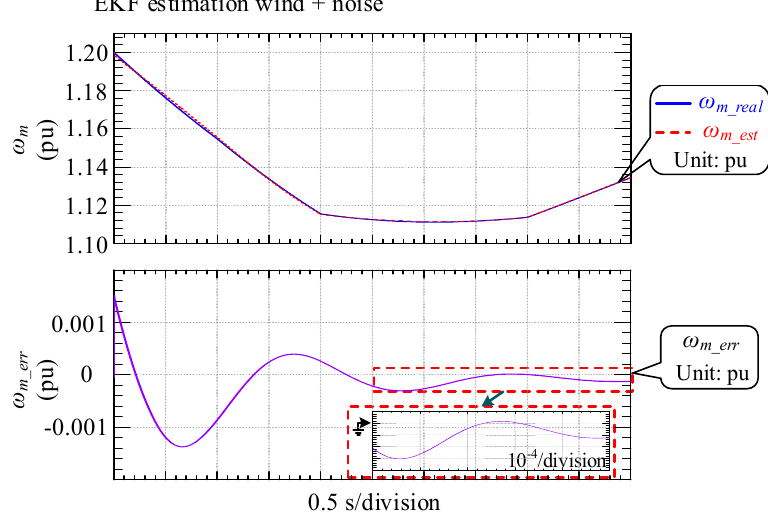
Figure 12. Real and estimated rotor angular speeds and the estimation error by using the EKF algorithm with wind speed fluctuation and measurement white noises injected at t = 0.1 s.